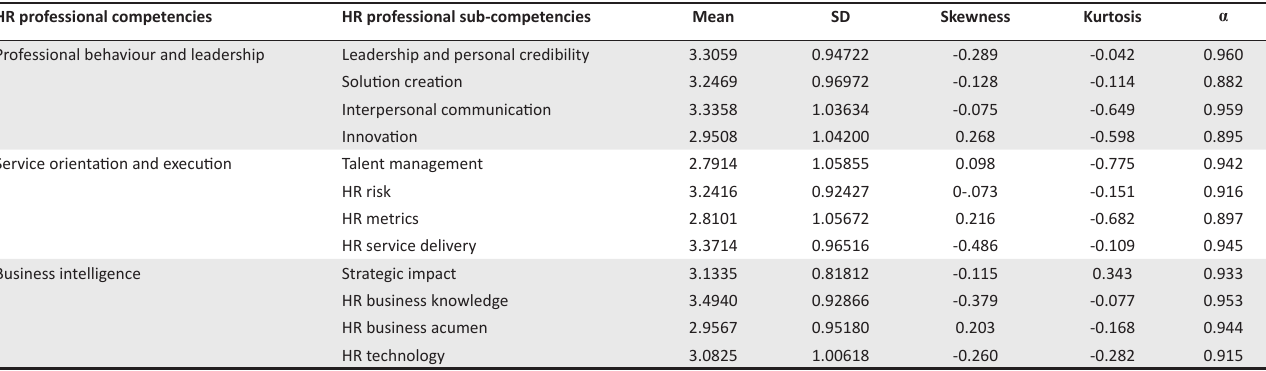
TABLE 2: Descriptive statistics of the factors.